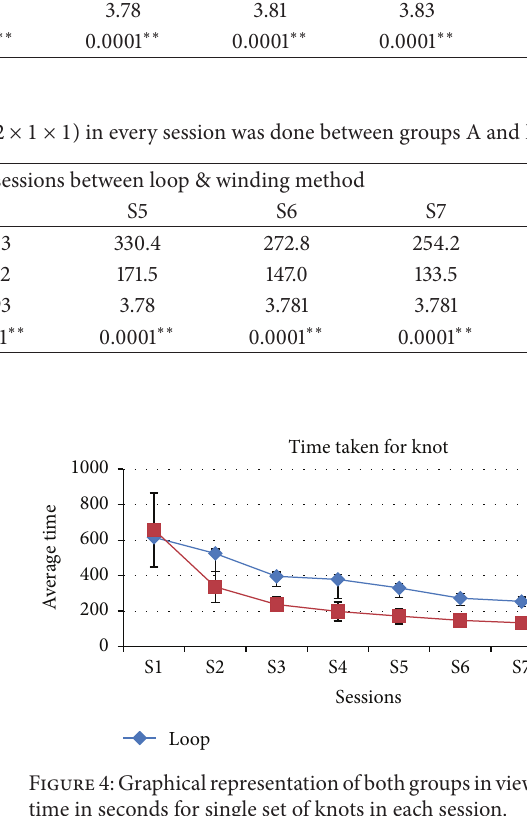
Figure 3: Graphical representation of both groups in view of number of knots in each session.